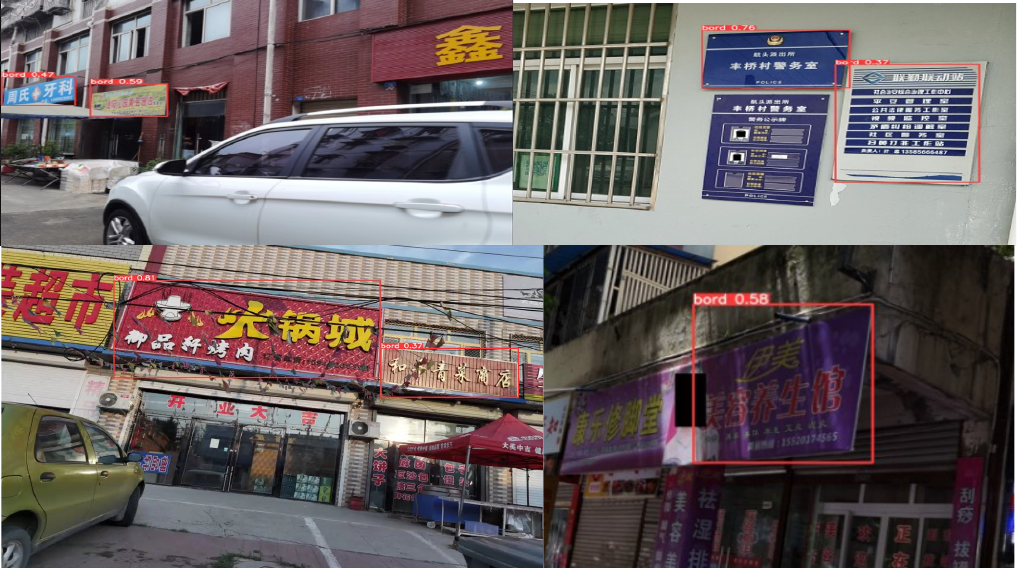
Figure 6. the results of billboard detection on test data using YOLOv5.